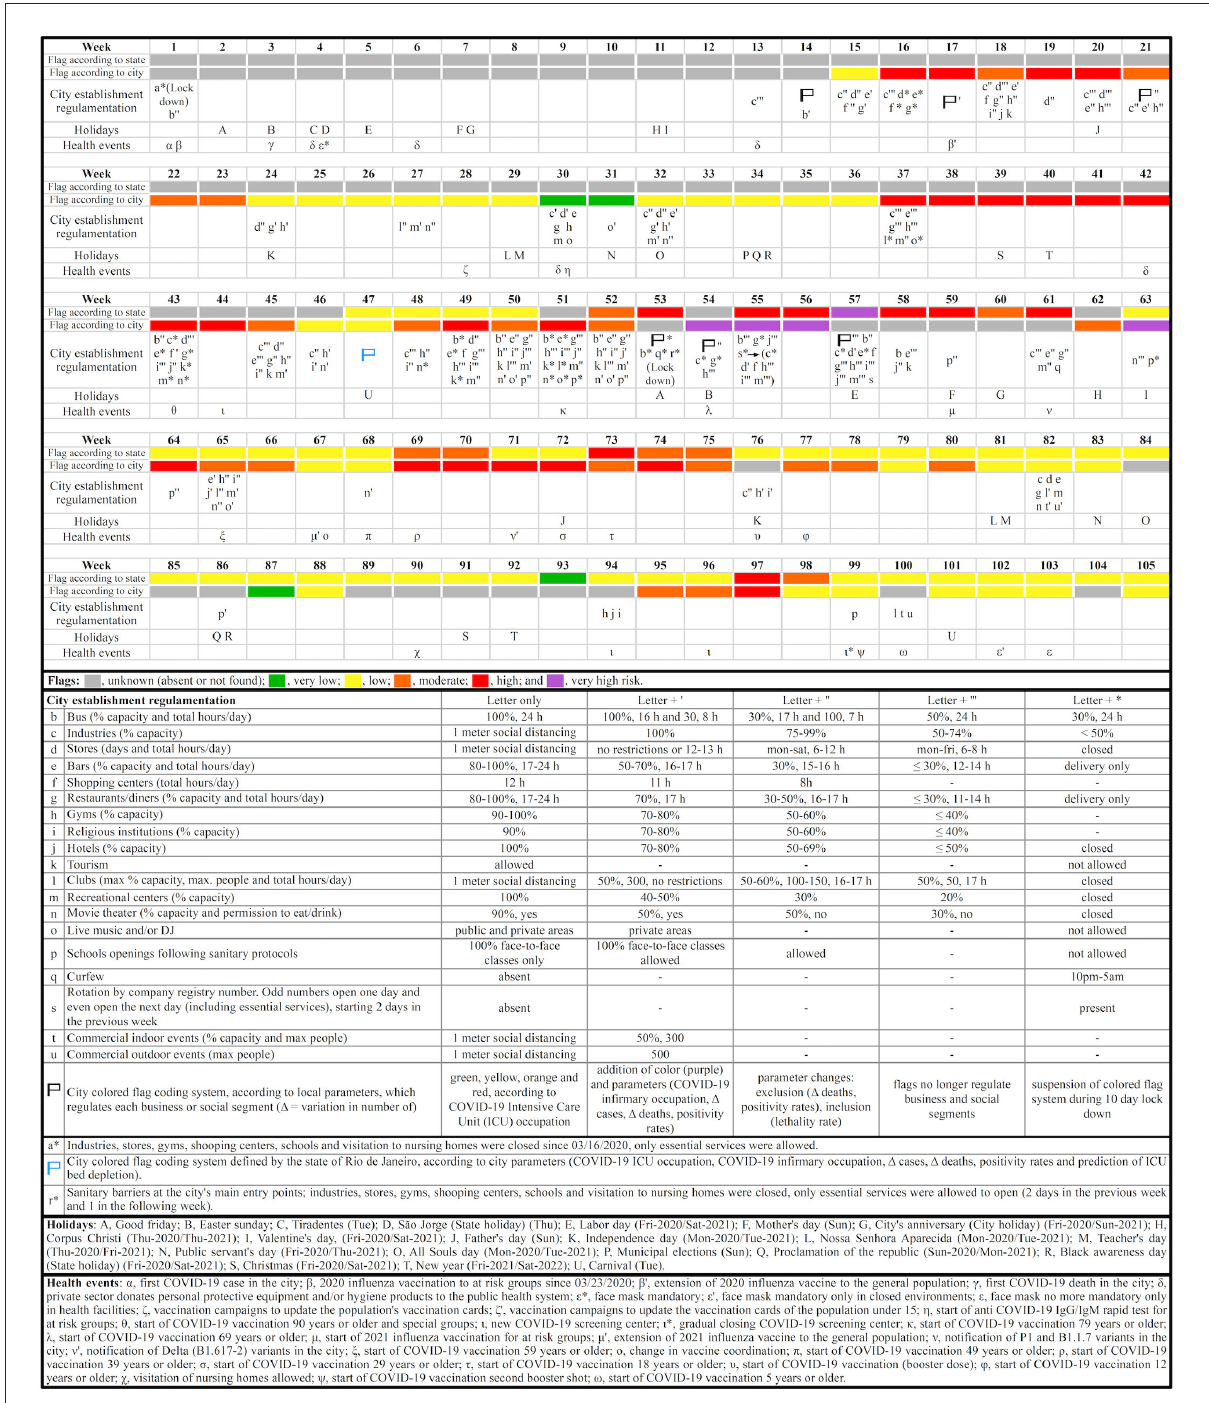
FIGURE2 Timeline highlighting the major municipal decrees, local health events, and municipal, state and national holidays in Nova Friburgo. Each lower case letter not represented in the following week indicates the permanency of the regulative measures from the previous one.